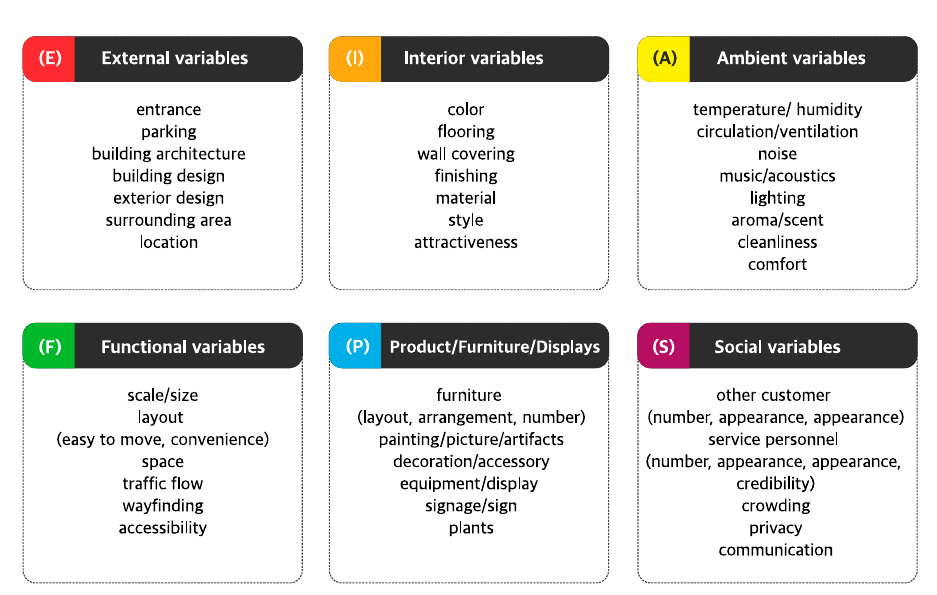
Figure 2. Classification of the six servicescape dimensions and factors .